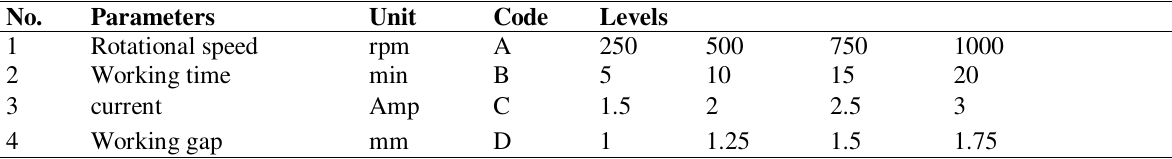
The selected parameters and their